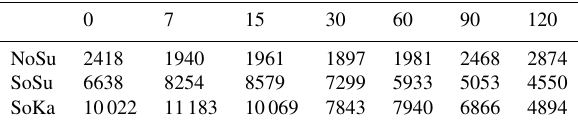
Table 3. Standard error of the regression for each region according to the number of days of rainfall accumulation. NoSu is northern Sumatra, SoSu southern Sumatra, and SoKa is southern Kaliman-